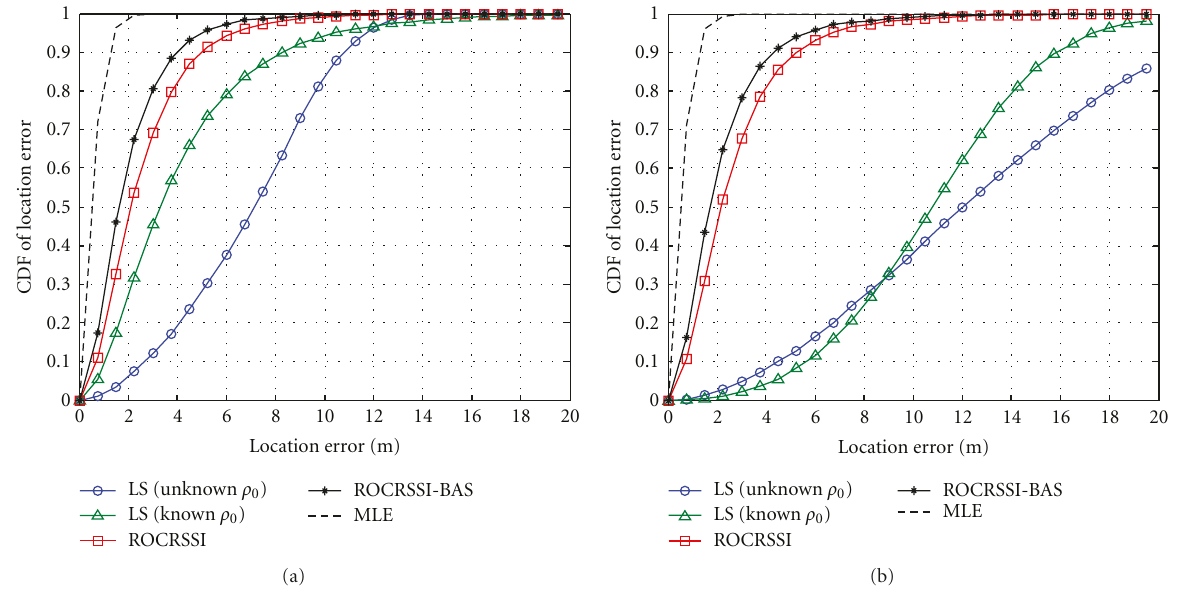
Figure 2: CDF of location error (a) no malicious anchors (b) 10% malicious anchors.